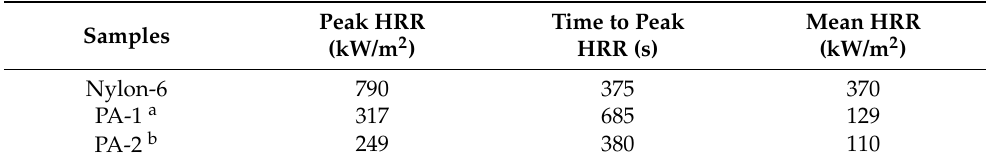
Table 1. Dependence of Peak HRR and Time to Peak HRR on composition for nylon-6 and